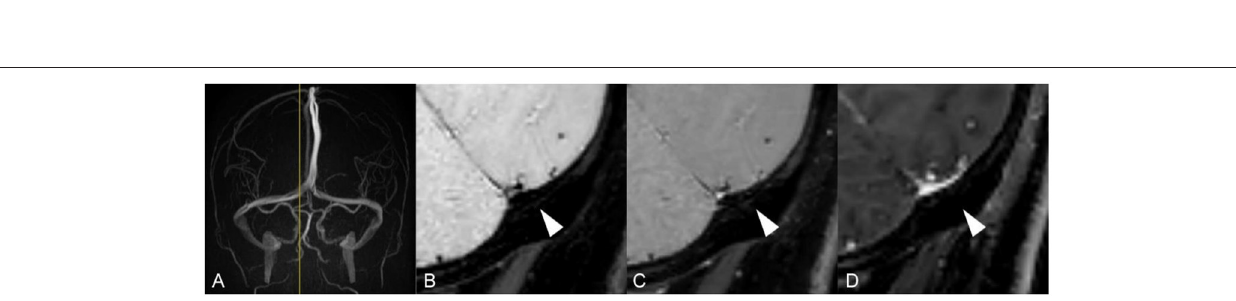
Frontiers in Neurology |